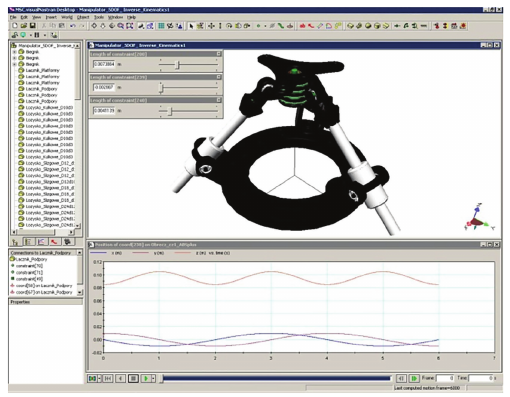
Figure 11: Theoretical movement path of the moving platform.